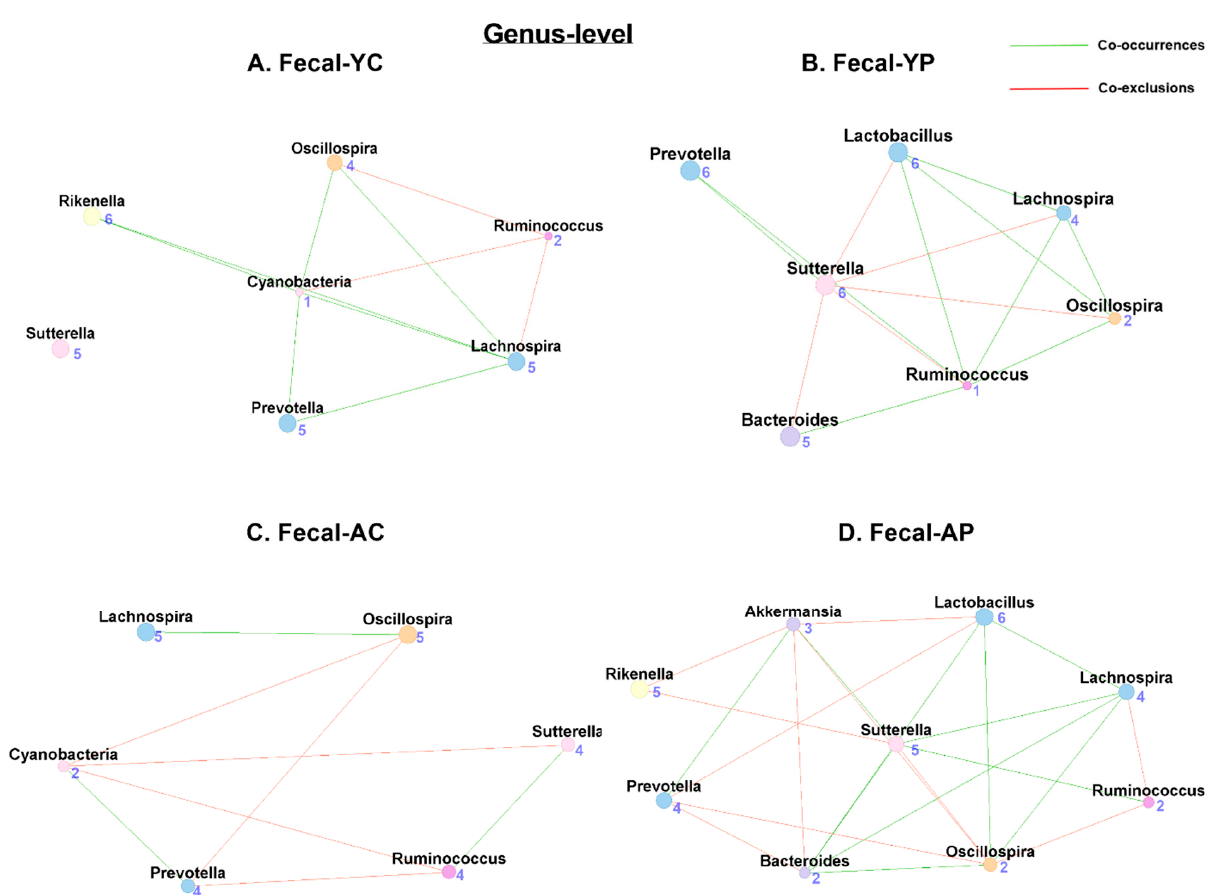
Figure 6. Microbial co-occurrence in the fecal microbiome in young and aging mice at the genus level. Co-occurrence networks were constructed based on relative abundance profiles using Kendall’s Tau correlation analysis in young control ( A ), young probiotic ( B ), aging control ( C ), and aging probiotic ( D ) groups. Each node represents a phylum. Each edge indicates the sign of the association (green = positive (co-occurrences), red = negative (co-exclusions)). The thickness of the nodes represents the level of association between taxa. Table 1. Summary of number of associations based on the Lactobacillus genus in all four groups across the sample types.